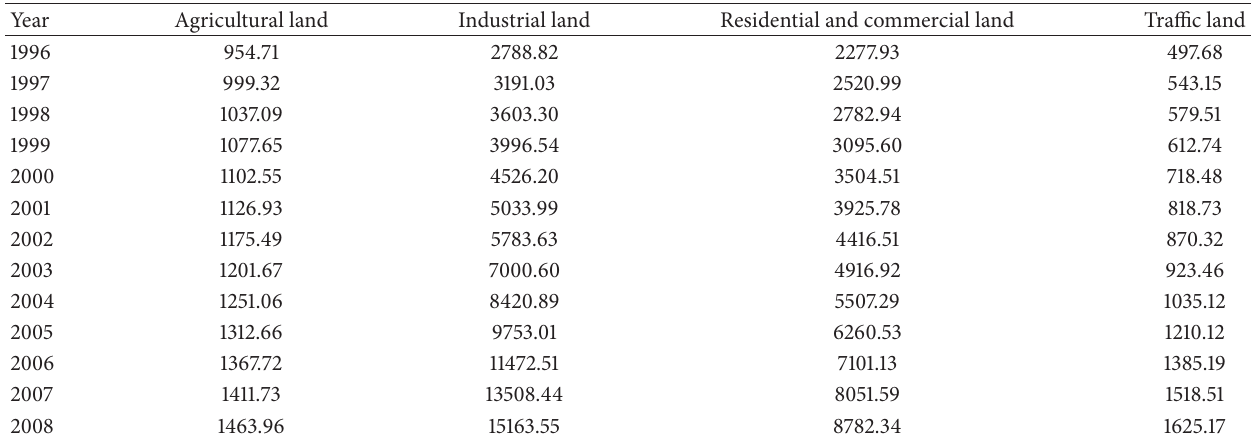
Table 12: GDP in different types of land use (100 million